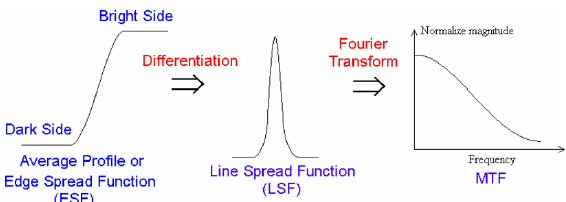
Figure 14. LSF & MTF estimation process from slant edges (Courtesy: Dennis Helder, Choi ).